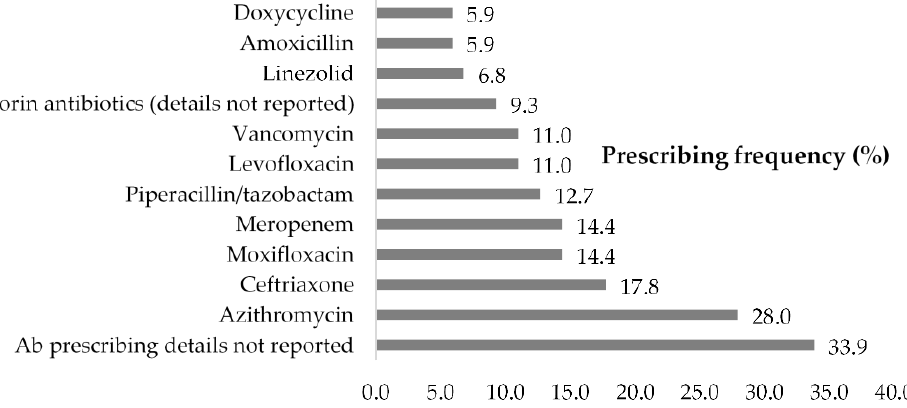
Figure 2. Frequently prescribed antibiotics for hospitalized COVID-19 patients.